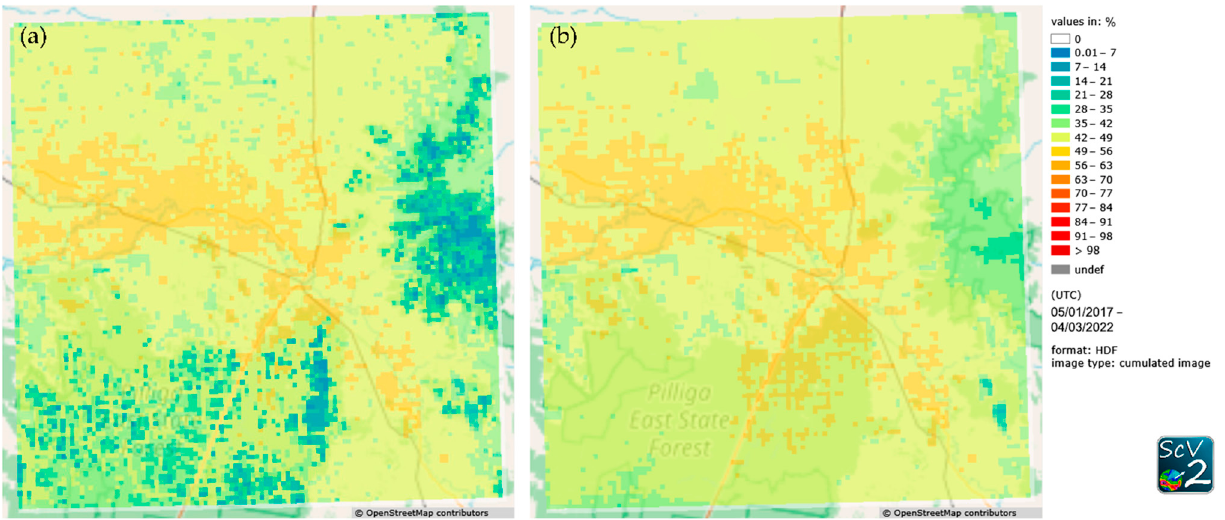
Figure 5. Data availability of soil moisture change in percent calculated as the difference between the soil moisture of consecutive days for scenario 1 ( a ) and for scenario 2 ( b ).